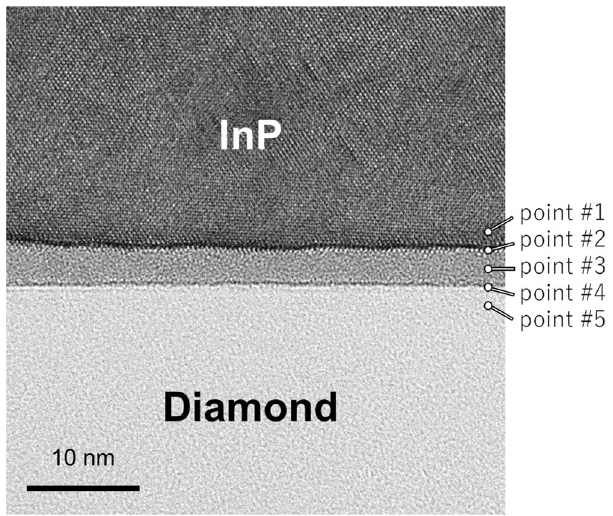
Figure 5. Cross-sectional TEM image of the InP/diamond bonding interface. The electron beam was set to emphasize the crystallinity of InP.